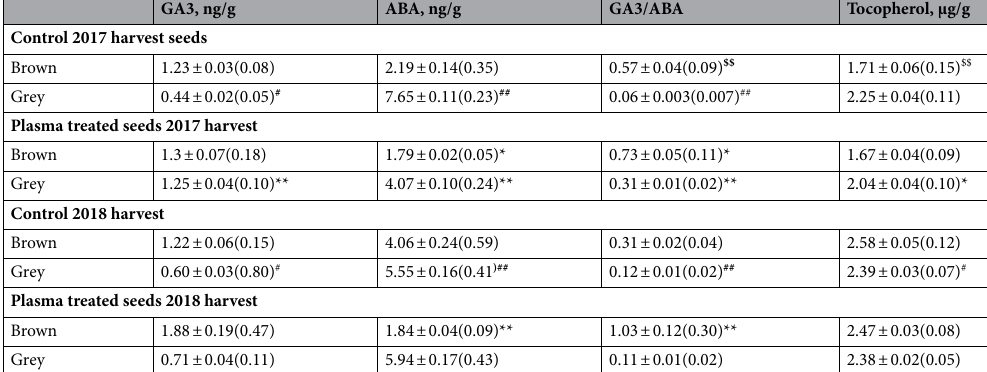
(ABA) (main phytohormones involved in the control of seed germination 27 ) and antioxidant γ-tocopherol (which is the main form of vitamin E in seeds 28 ) in radish sprout seeds. For this, we crushed the seeds and extracted phytohormones in methanol (99.9%) for 24 h at 4 °C (details are described below). The obtained supernatant was used for mass spectrometry analysis to detect the concentration of GA3, ABA, and γ-tocopherol. The obtained results showed that the amounts of GA3 and ABA in control seeds were strongly dependent on the seed color (Table 1). Particularly large difference was in seeds harvested in 2017: the amount of GA3 in brown seeds was 2.8 times larger, and the amount of ABA was 3.5 times smaller compared to the corresponding amounts in control grey seeds. These findings indicate that the decreased germination capacity of grey seeds (2017) (Fig. 2) compared to all other seed groups may be explained by their highest content of the germination inhibitor ABA and the lowest GA3/ABA ratio (9.5 times smaller in grey seeds compared to the brown ones). Differences in the content of phytohormones were less strong for seeds of different colors harvested in 2018. The amount of ABA was by 27% higher, and the amount of gibberellin A3 was 2 times smaller (GA3/ABA ratio 2.6 times smaller) in grey seeds than brown seeds. Thus, the same color-dependent tendencies were displayed as between grey and brown seeds harvested in 2017. Plasma treatment did not change the amount of GA3 in brown seeds of the 2017 harvest. However, in grey seeds treated with plasma GA3 amount increased 2.8 times (Table 1). The amount of ABA was reduced after plasma treatment much stronger (47%) in grey seeds than brown seeds (18%) harvested in 2017. Plasma induced increase of GA3/ABA ratio was in grey seeds (5.2 times) was also remarkably larger as compared to the growth observed in the brown seeds (28%) (Table 1). Changes in the content of phytohormones induced by plasma treatment in seeds harvested in 2018 were smaller than the respective changes in older (2017) seeds. Changes in the ratio of GA3/ABA was statistically insignificant both for grey seeds but significant for brown seeds (2018 harvest). Thus, the largest increase in the GA3 to ABA ratio was observed in grey seeds harvested in 2017 after plasma treatment. Since ABA is an inhibitor of germination and GA stimulates germination 27 , the observed stimulation of germination in grey seeds (2017) after plasma treatment (Fig. 2a) is in good agreement with changes in the amounts of phytohormones. The amount of γ- tocopherol in radish sprout seeds was considerably higher in comparison to amounts of phytohormones (Table 1). The brown seeds harvested in 2018 were 50% higher compared to that in brown seeds harvested in 2017, indicating that antioxidant amount decreased in seeds during storage due to aging. However, the γ- tocopherol amount was approximately the same in grey seeds harvested in 2018 and 2017. Plasma did not change significantly γ- tocopherol amount in brown seeds harvested both in 2017 and in 2018, as well as in grey seeds harvested in 2018. However, the γ- tocopherol amount decreased by 10% in 2017-harvest year grey seeds, indicating possible oxidative damage induced by plasma treatment. Thus, older grey seeds (2017) showed larger changes in the amounts of GA3, ABA, and γ- tocopherol after plasma treatment compared to other seed groups. The changes in phytohormones in grey seeds (2017-harvest) are consistent with the previously reported work 29 . The content of GA increases and ABA decreases, and their correlation with plasma effects on germina- tion in freshly harvested seeds 29 . SEM and EDX analysis of grey seeds before and after plasma treatment. Among all the radish seed samples, 2017-harvest grey seeds displayed significant changes in phytohormone amounts, germination, and sprout growth after plasma treatment (Figs. 1–3 and Table 1). Therefore, to explore the physical changes in grey seeds after plasma treatment, we performed the SEM and EDX analysis (details are described below). Figure 6a,b, and Figure S4 show the SEM images representing the modification of the radish seed surface struc- ture after DBD plasma treatment. It seems that after plasma treatment, there were no significant changes on the